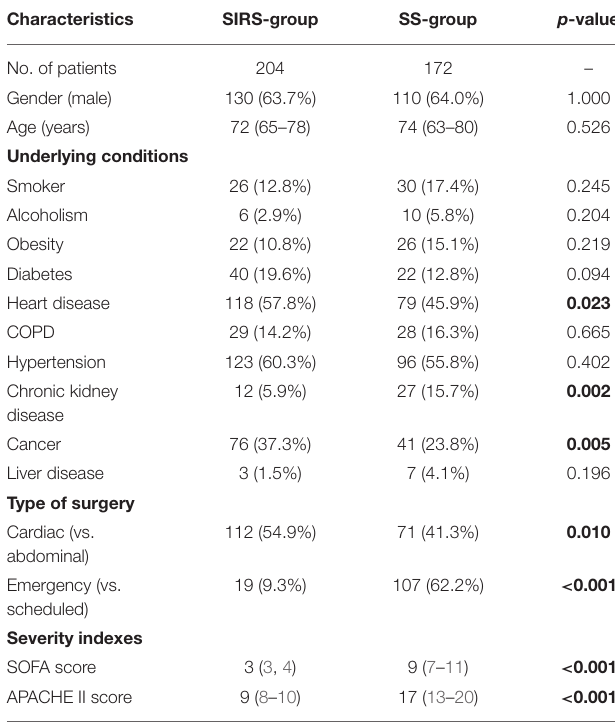
TABLE 1 | Demographic and clinical characteristics of patients with SIRS (SIRS-group) and with septic shock (SS group) who underwent major surgery.